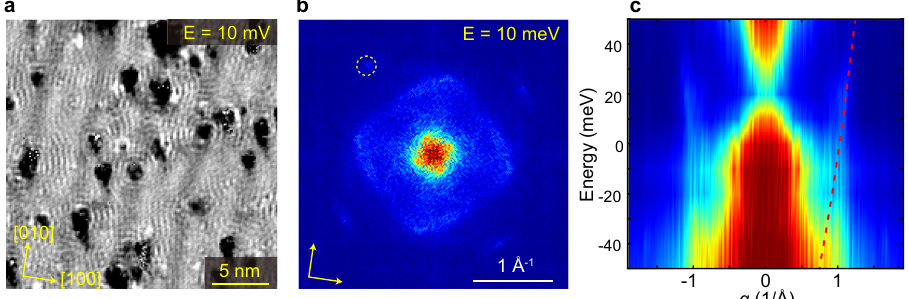
Fig. 5 QPI measurement on Cr (001) surface. a d I /d V image taken at V b = 10 mV ( I = 100 pA), which shows the QPI modulation. b The four-fold symmetrized FFT image of at E = 10 meV. The dashed circle indicated the FFT spots from c(2 × 2) reconstruction. c Color plot of the summarized FFT line cuts, dashed line tracks the dispersion of electron-like